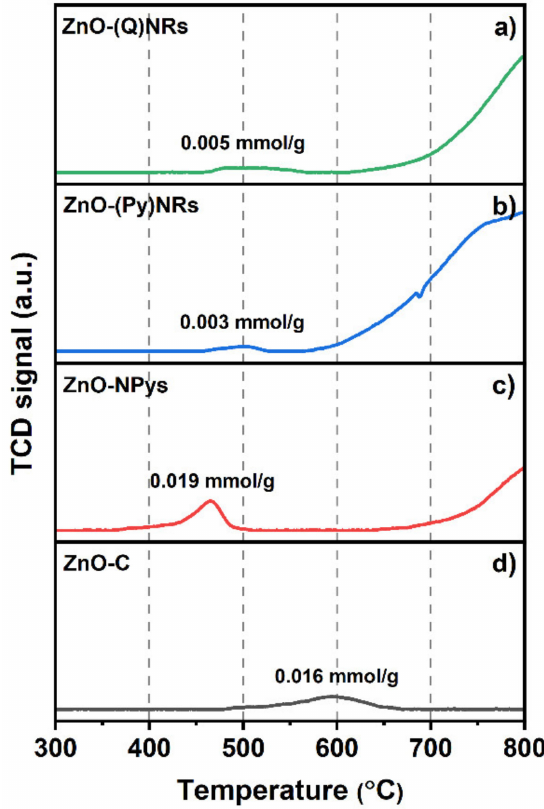
Figure 4. H 2 Temperature-programmed reduction curves of pristine ( a ) ZnO-(Q)NRs, ( b ) ZnO-(Py)NRs, ( c ) ZnO-NPys, and ( d )